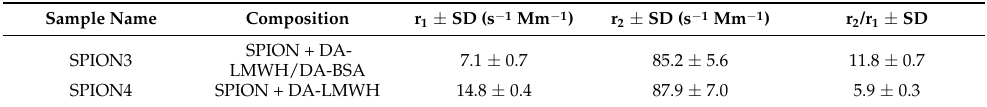
Figure 9. The R 1 (left) and R 2 (right) values of both samples, plotted against the effective Fe ion concentration. The linear fitting is shown, from which the slopes r 1 and r 2 are extracted. Note that the scale of the r 2 graph is 10× the scale of the r 1 graph, since the r 2 relaxation is more intense by one order of magnitude. Table 4 reports the relaxometric parameters of SPION samples. Table 4. Relaxometric parameters of SPION samples.